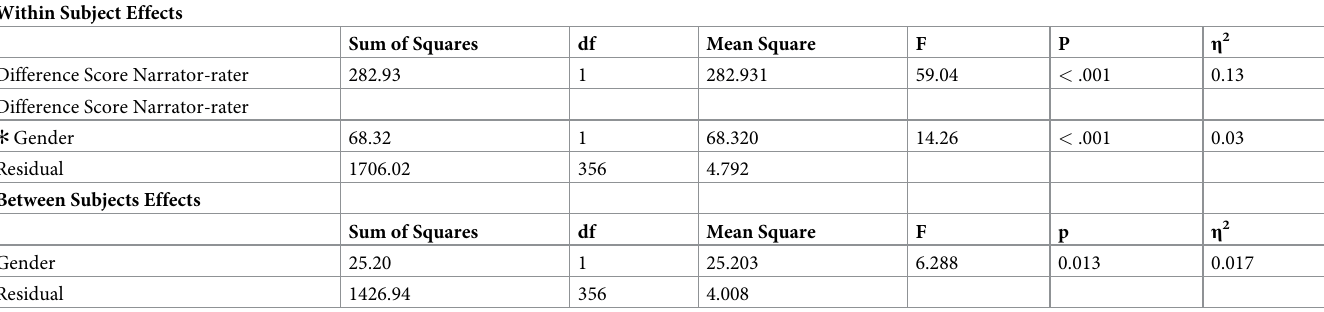
Table 3. ANOVA tables for difference score between narrator and rater by type of violence, gender reversed narratives, Phase 3.